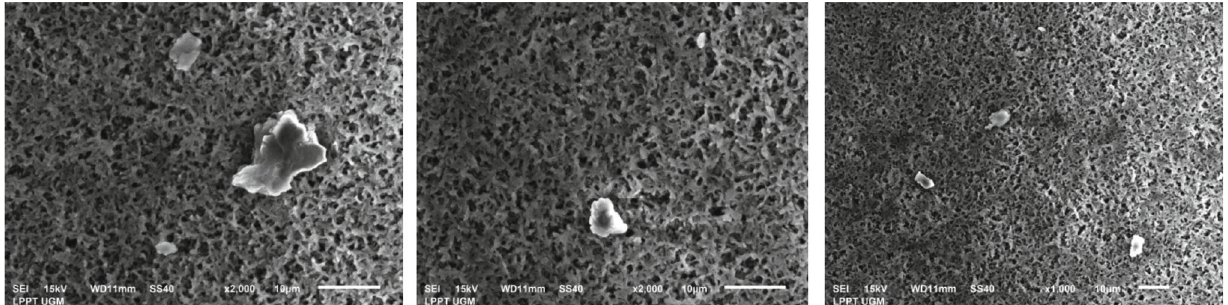
Figure 1: Particles from the air captured using fi lter nylon membrane 0.2 μ m and examined using SEM. Some particles have a diameter of < 10 μ m.